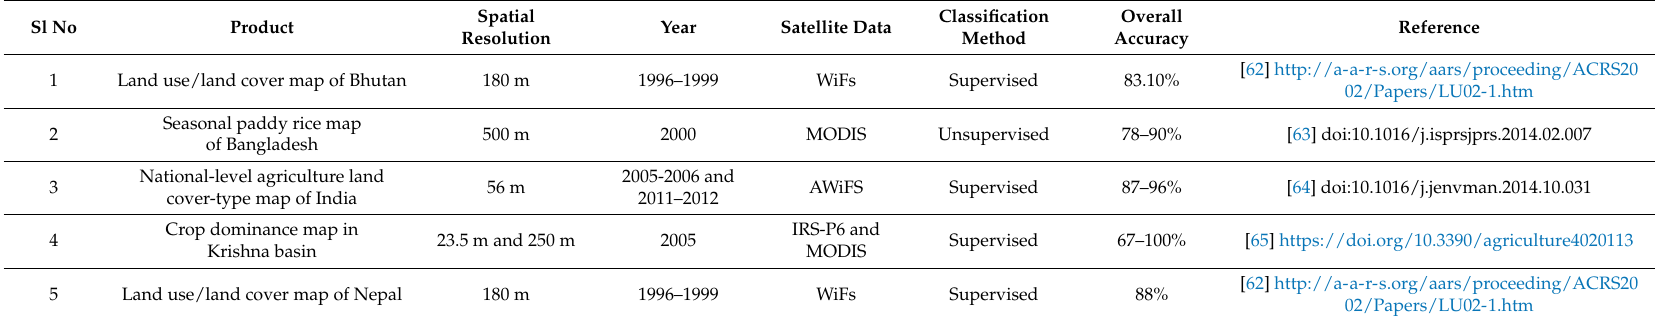
Table 4. Summary of the available national level land cover and cropland